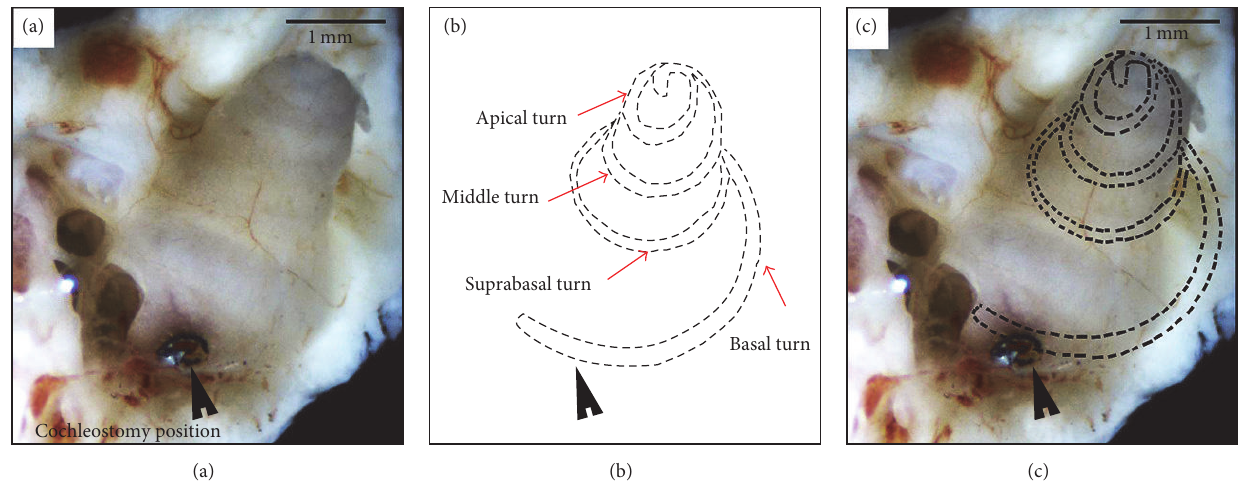
Figure 1: Cochleostomy was performed in the basal turn near the round window. (a) The perforation as the black arrow showed the cochleostomy position. (b) The cochlear membrane was delineated with dotted lines. The red arrows located the specimens from the basal turn, suprabasal turn, middle turn, and apical turn. (c) The site of the simulated cochlear membrane under the bone. Scale bar: 1mm.